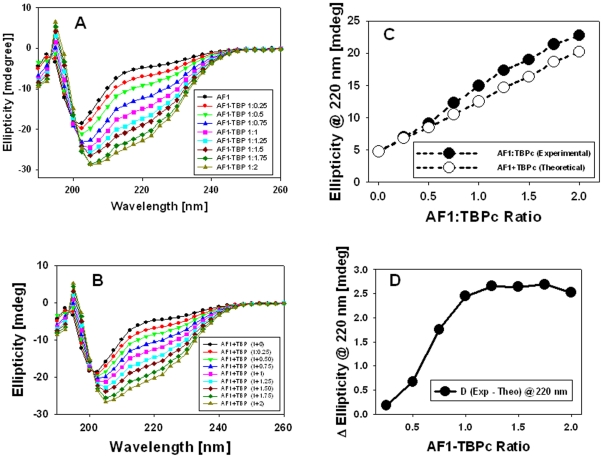
Secondary structural changes in the AF1∶TBPC complex.
A) Far-UV CD spectra of the GR AF1∶TBPC complex (experimental) at a constant AF1 and varying concentrations of TBPC (as indicated). B) Far-UV CD spectra of the GR AF1+TBPC (theoretical sum) at a constant AF1 and varying concentrations of TBPC (as indicated). C) A comparison of changes in the ellipticity at 220 nm for experimental and theoretical sums with respect to AF1∶TBP ratio. D) TBP-induced conformational transition of AF1 as measured in terms of changes in the ellipticity at 220 nm, and plotted against AF1∶TBPC ratio.